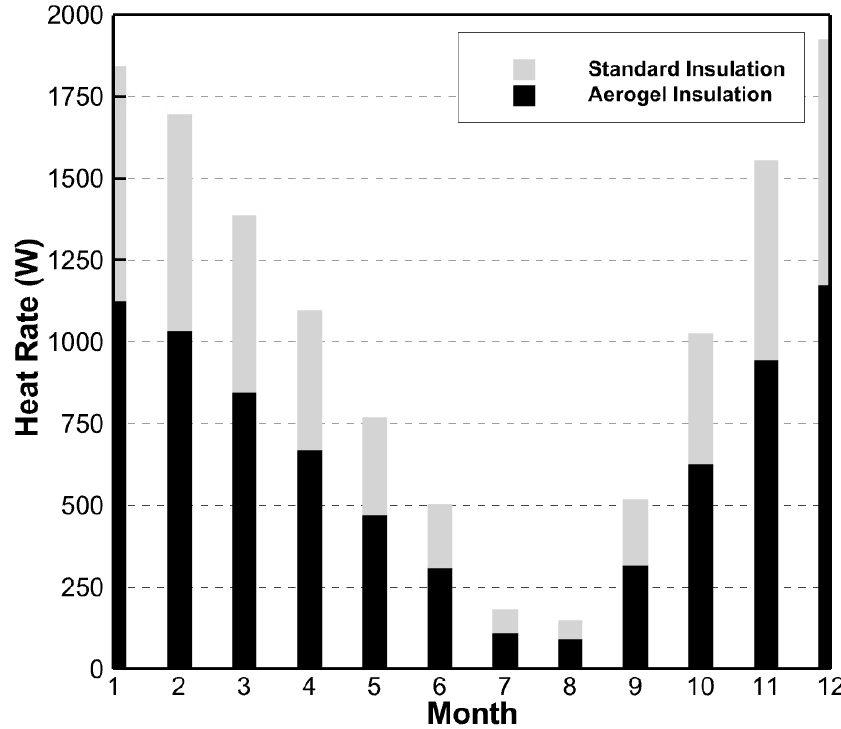
Figure 3. Simulation results of rate of heat lost through house windows comparing aerogel to standard insulation.